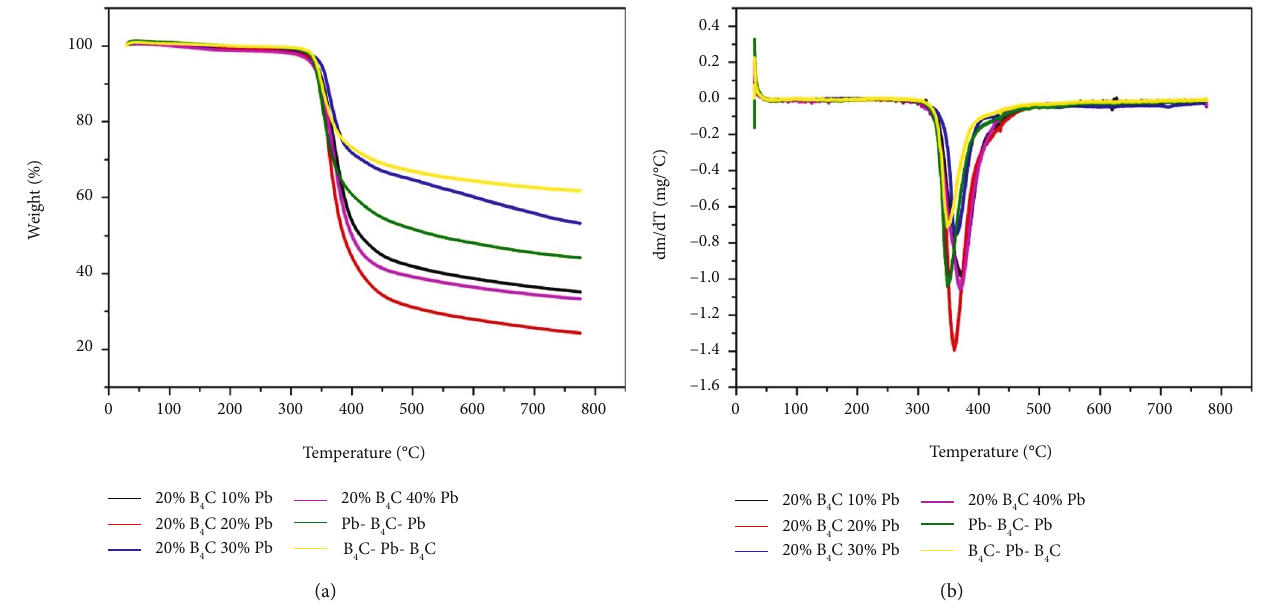
Figure 3: (a) Primary thermograms of samples and (b) derivative thermograms of samples.